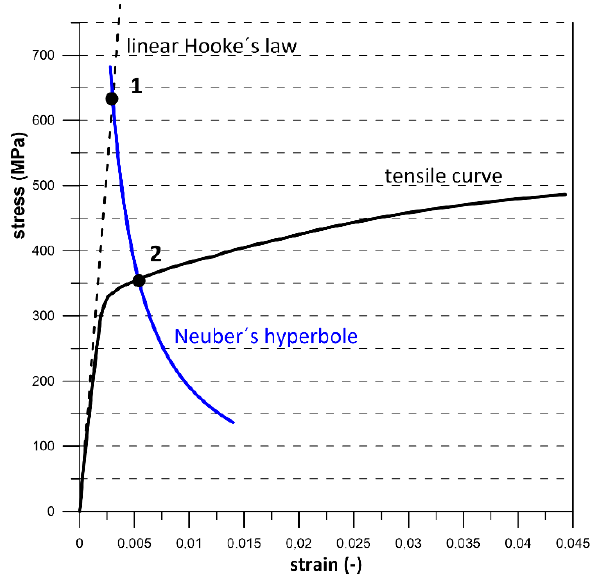
Figure 10. Application of the Neuber method of transforming the value of the nominal stress of 144 MPa into the root of the thread ( 1 —633 MPa, 2 —352 MPa).